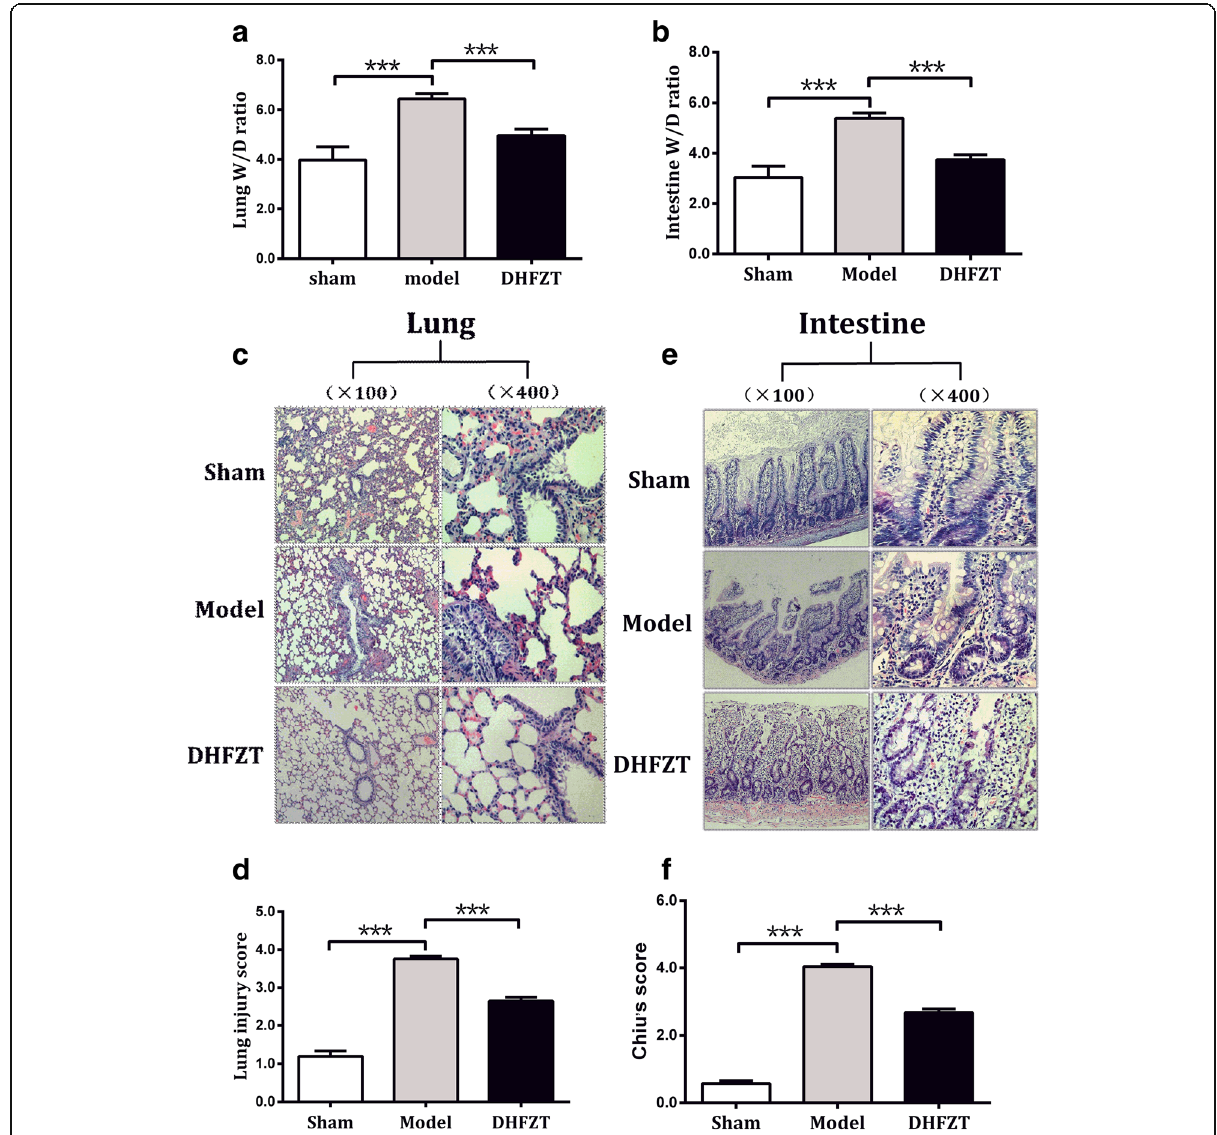
Fig. 4 DHFZT attenuates edema and pathological damage of lung and intestine associated with SAP. a and b :W/D ratio of lung and intestine changes at 48 h in sham group, model group and DHFZT group. c and d : pathological damage and injury score of lung changes at 48 h in each group. e and f : pathological damage and injury score of intestine changes at 48 h in each group. Histologic change of lung and intestine were observed under light microscopy (hematoxylin and eosin, ×200 and ×400 respectively). W/D ratio, wet weight value/dry weight value ratio, DHFZT: Dai-Huang-Fu-Zi-Tang group. The results are mean ± SEM. *** P <